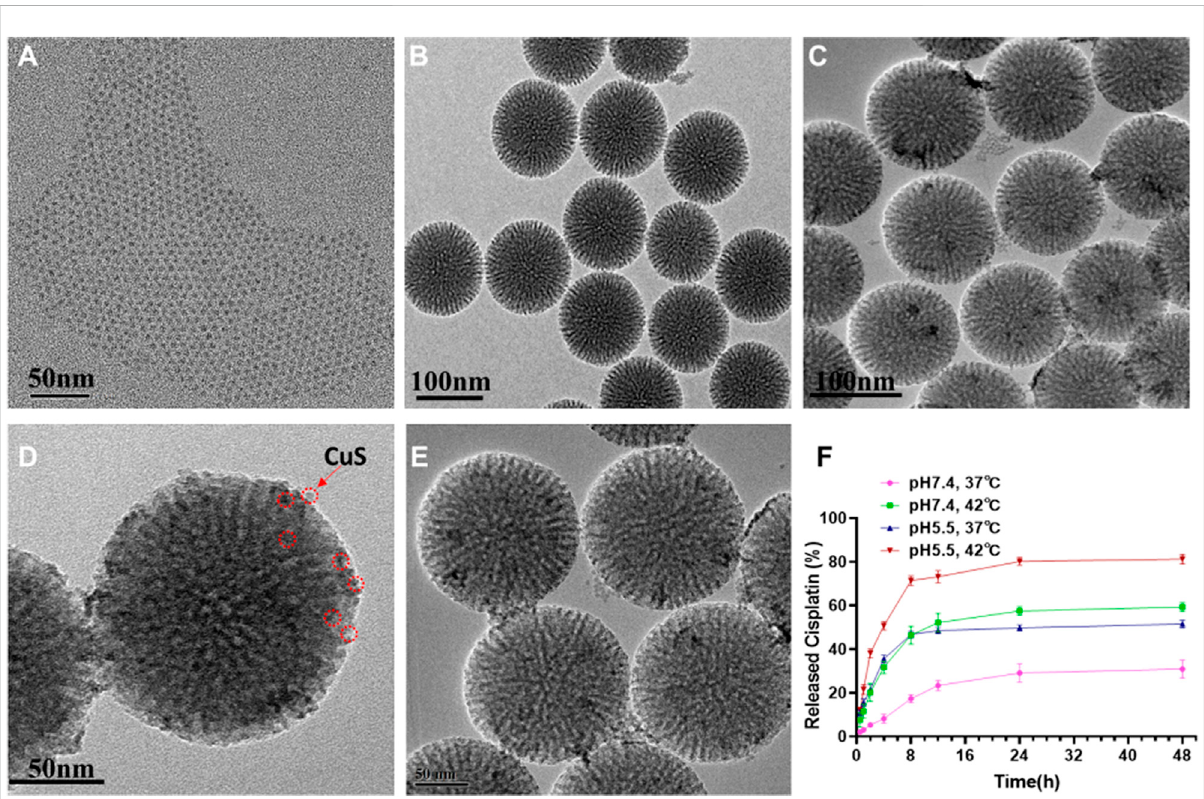
FIGURE 2 Characterization of CDDP@m-CuS-PEG NPs. (A) TEM image of CuS quantum dots; (B) TEM image of mSiO 2 -NH 2 NPs; (C,D) TEM image of m-CuS-PEGNPs; (E) TEMimageofCDDP@m-CuS-PEG; (F) Cisplatinreleasepro fi lefromCDDP@m-CuS-PEGatdifferentpHconditions(pH7.4and pH 5.5) and temperature (37 or 42 ° C), respectively, n =